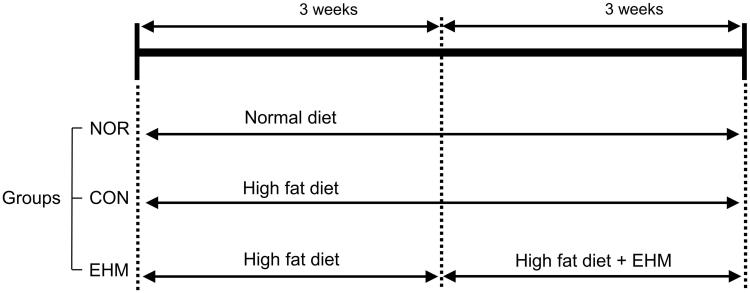
Hyperlipidaemia induction in mice and EHM administration. The mice were fed a normal or high-fat diet (HFD) for 6 weeks before group assignment. EHM was orally administered to the EHM group for the last 3 weeks. NOR: normal diet-fed control mice (n = 8), CON: HFD-fed hyperlipidaemic mice (n = 8), EHM: HFD-fed and EHM-administered mice (n = 8).